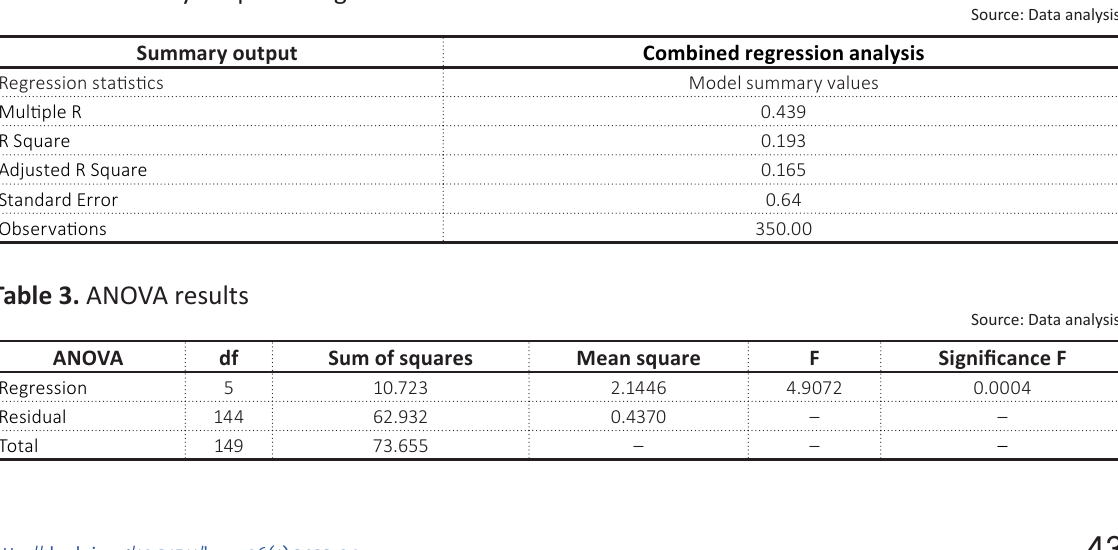
Table 2. Summary output of regression combined for male and female students